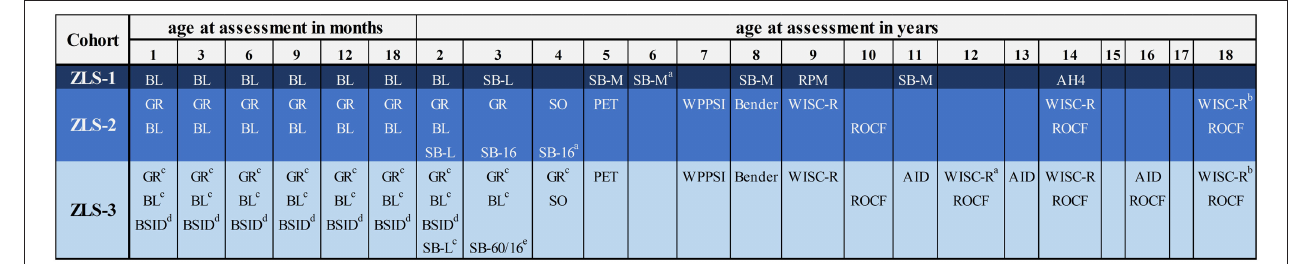
FIGURE 8 | Instruments to assess cognitive abilities in ZLS-Childhood. AH4: AH4 Group Test of General Intelligence (Heim, 1970). AID: Adaptives Intelligenz-Diagnostikum (“Adaptive Intelligence Diagnostics”) (Kubinger and Wurst, 1985). Bender: Bender’s Visual Motor Gestalt Test (Clawson, 1962). BL, Brunet-Lézine Test (Brunet and Lézine, 1951); BSID, Bayles Scales of Infant Development (Bayley, 1969); GR, Griffiths Test (Griffiths, 1954); PET, Psycholinguistischer Entwicklungstest (German adaptation of the “Illinois Test of Psycholinguistic Abilities”) (Angermaier, 1974); RPM, Raven’s Progressive Matrices (Raven, 1947, 1956); ROCF, Rey-Osterrieth Complex Figure (Rey, 1941); SB-L/SB-M, Stanford-Binet Test of Intelligence L-Form/M-Form (Terman and Merrill, 1937; Lückert, 1957); SB-16, Stanford-Binet Test of Intelligence 1916-version (Terman, 1916); SB-60, Stanford-Binet Test of Intelligence 1960-version (Terman and Merrill, 1960; Terman et al., 1965); SO, Snijders-Oomen Non-Verbal Intelligence Tests (Snijders-Oomen, 1977); WISC-R, Wechsler-Intelligence Scale for Children-Revised (German version; Tewes and Titze, 1983; Willich and Friese, 1994). a Applied only in a small subgroup of study participants. b Selected subtests only (Similarities, Vocabulary, Digit Span, Picture Arrangement, Block Design, Object Assembly). c Tests were omitted from the assessment protocol over the course of the study (i.e., approx. after the 140th participants). d Task was only introduced in the course of the study (i.e., approx. after the 120th participant). e Until 1983: 1916-version was applied, after 1984: 1960-version was